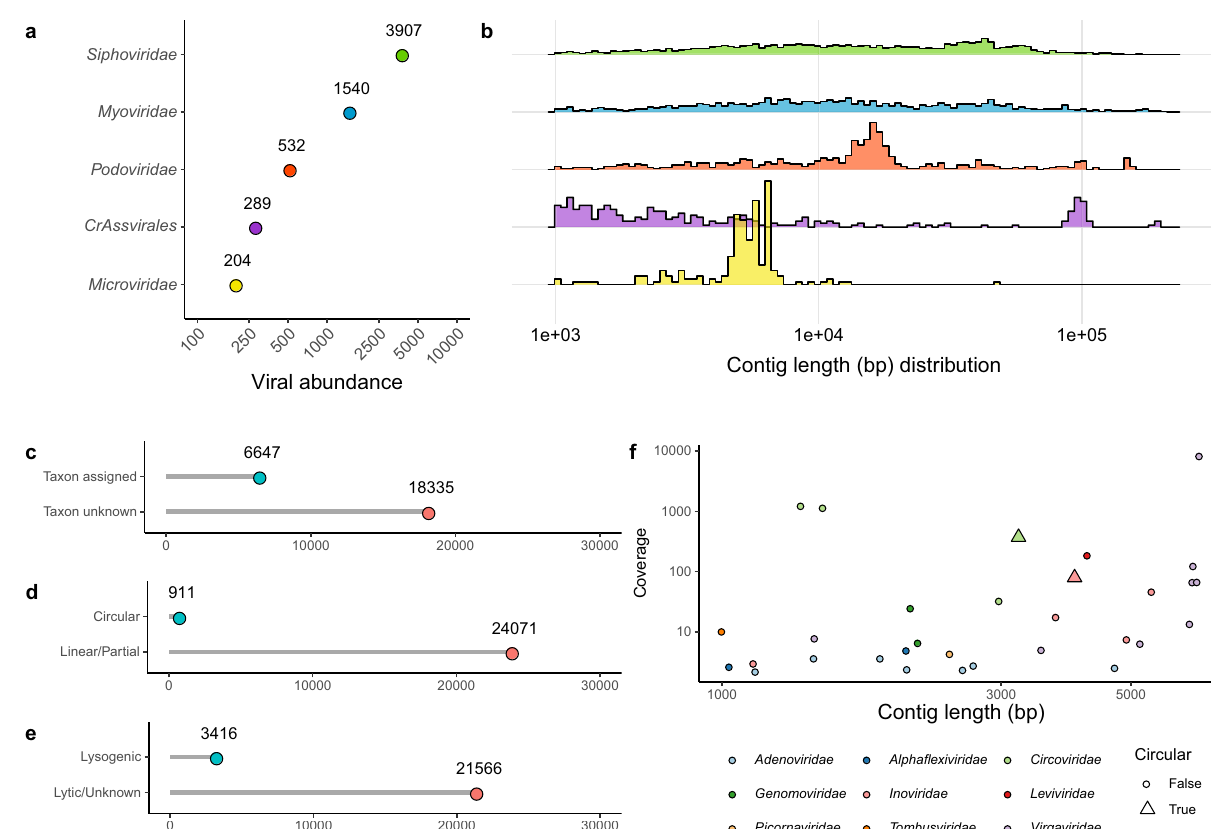
Fig. 1 Overview of unampli fi ed faecal viromes detected in control and IBD subjects. a The frequencies of the most abundant viruses assigned familial taxonomic ranks, showing b their contig length distributions. The number of viruses identi fi ed in this study that ( c ) could be assigned a taxonomic rank, d characterised as circular (True = circular; False = non-circular partial sequence/linear), or e encoding genes for phage lysogenic replication. f The contig length relative to sequence coverage for infrequently detected eukaryotic faecal viruses that could be assigned a taxonomic